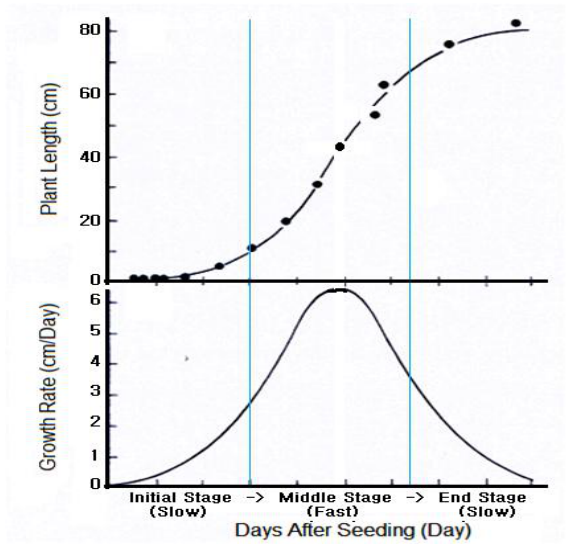
Figure 1. General plant growth characteristics.